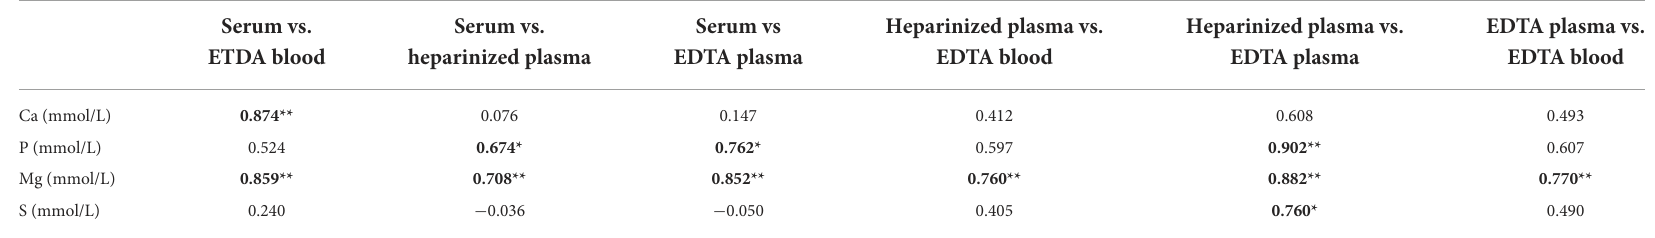
TABLE 7 Pearson’s correlation coefficients for major elements in different blood specimens ( n = 10).